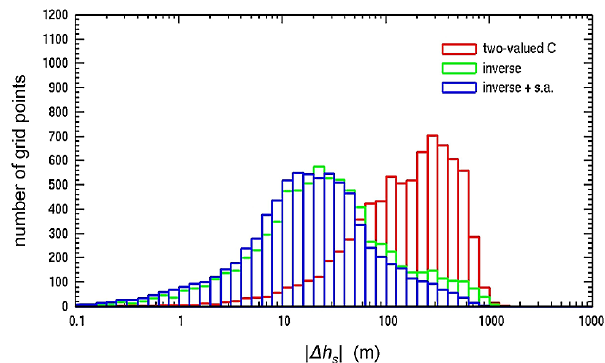
Fig. 2. Histograms of the magnitude of surface ice elevation errors | 1h s | (m) vs. number of grid cells over all grounded ice. Elevation error bins are in equal increments of log 10 ( | 1h s | ) . Red: using two- valued basal sliding coefficient distribution as in Fig. 1a. Green: using inverse method as in Fig. 1d. Blue: using inverse method with sub-grid topographic influence as in Fig.